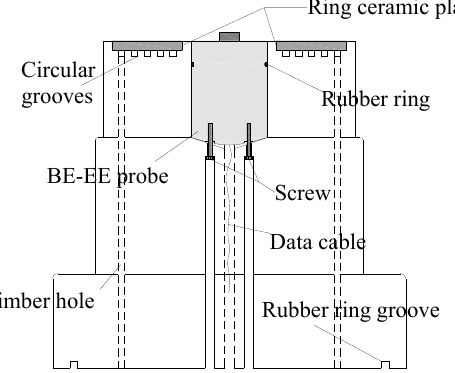
Figure 2. Schematic diagram of the improved RC pedestal .